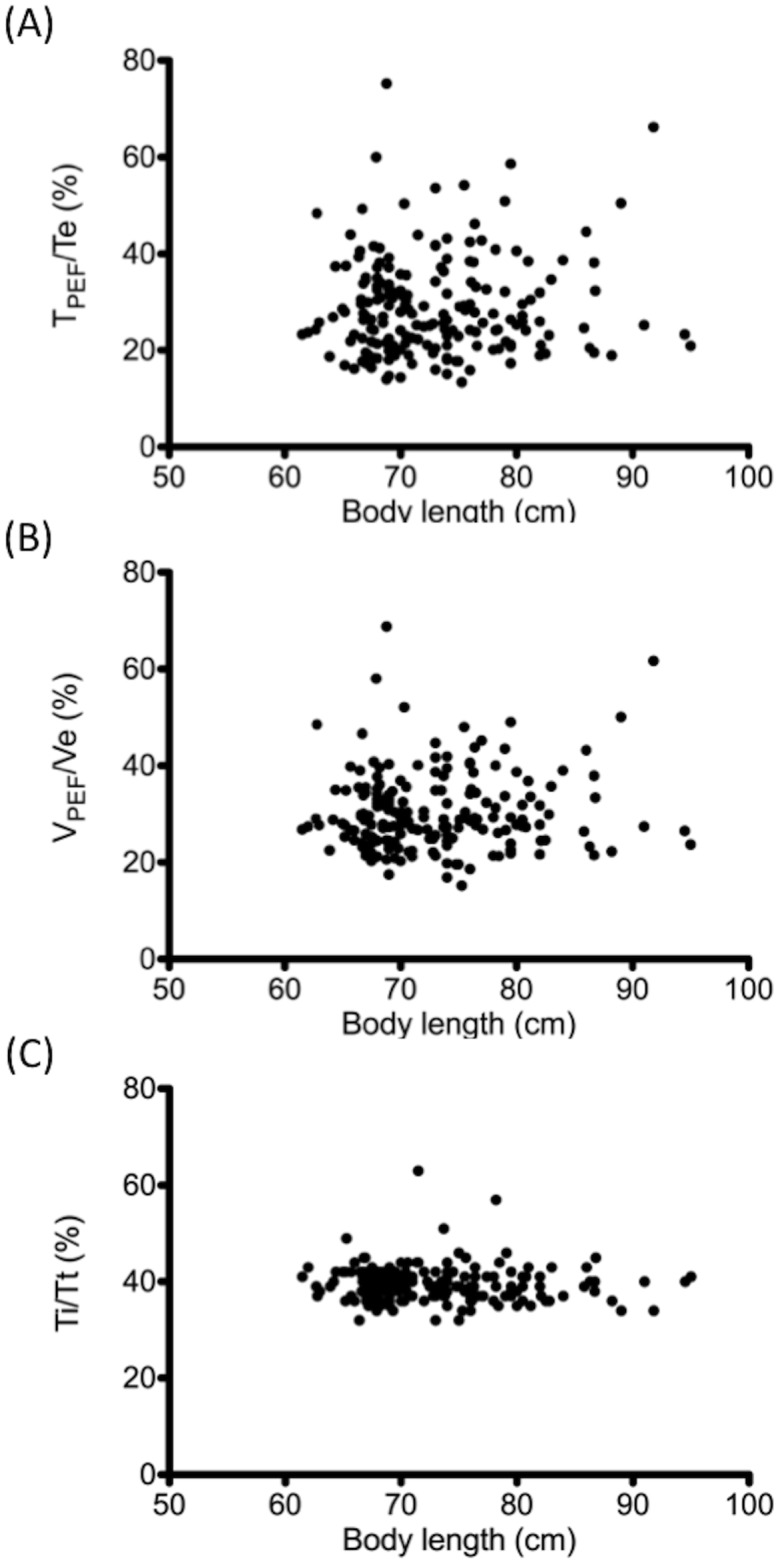
Parameters for tidal breathing analysis.Scatter plots of (A) TPEF/Te, (B) VPEF/Ve, and (C) Ti/Tt in tidal flow waveform are indicated against crown-heel length at the time of the test.